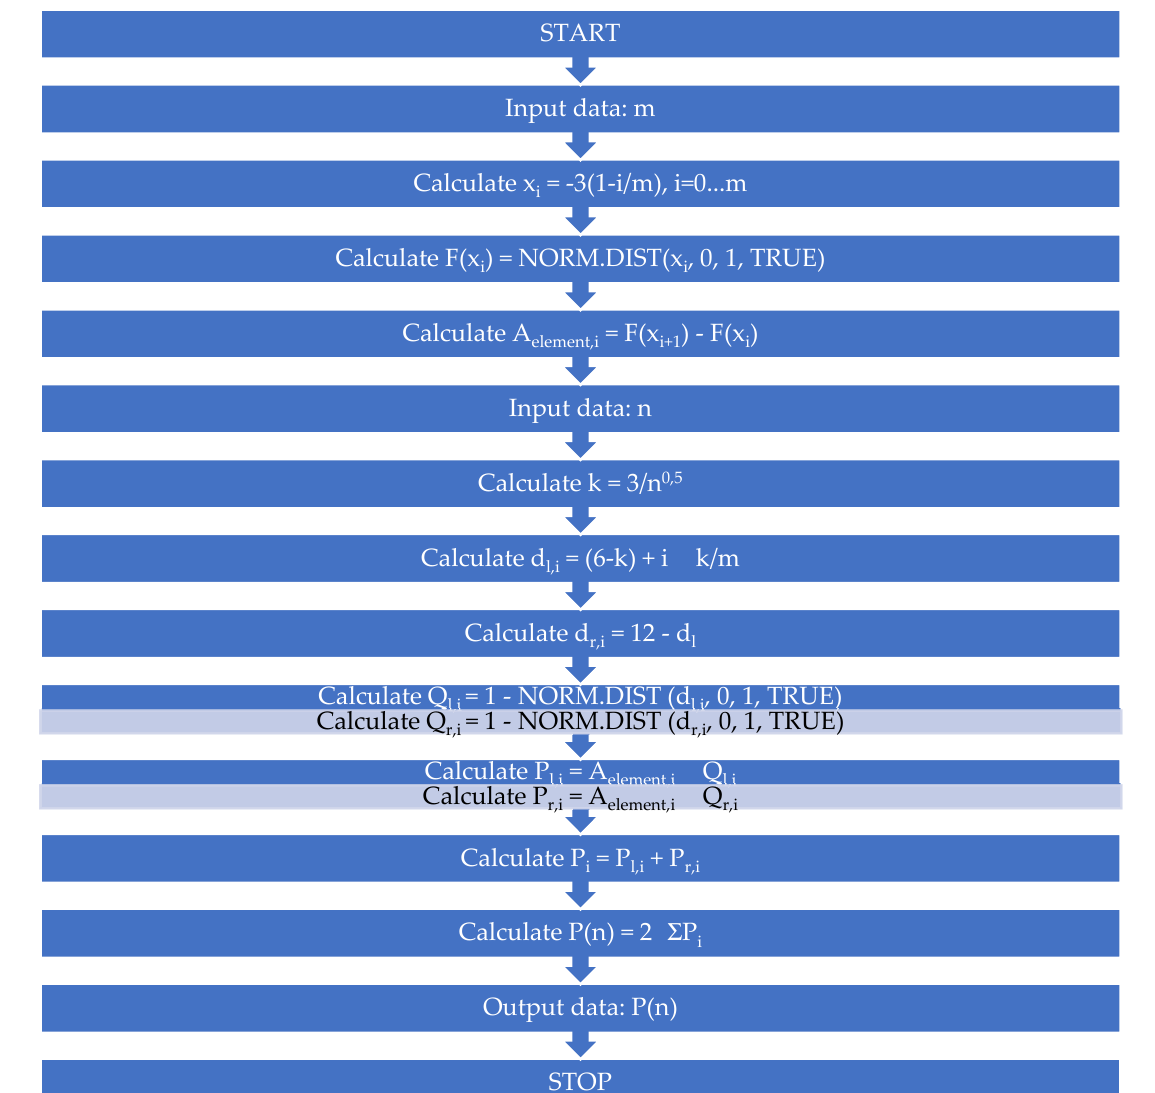
Figure 7. The flowchart for the calculation program created with Microsoft Excel software. The final results obtained for the finest work steps (0.1; 0.05; 0.02; 0.01), to obtain the